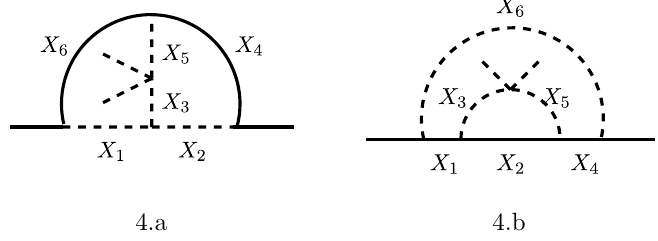
Figure 4. Two-loop diagrams for Class 4.a and 4.b of Category 4.